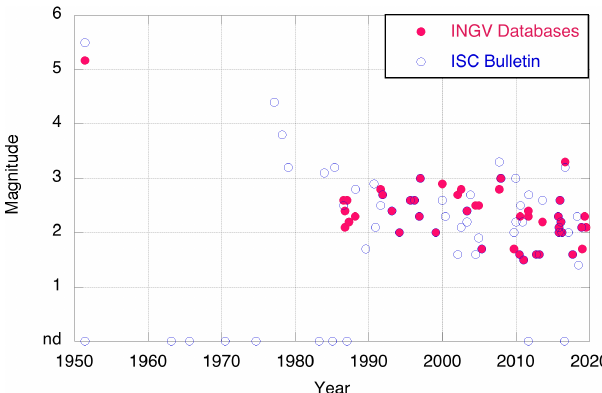
Figure 4. Magnitude versus time plot of earthquakes located within 30km distance of the reservoir, as reported in the INGV databases and ISC Bulletin. The INGV data come from CPTI15 (Rovida et al., 2021) and ISIDe databases (ISIDe, 2007): 46 events with M > 1.5 are reported in the time interval 1985–2019. The ISC data start with the 1951 event and end in 2018. Magnitudes are not uniform and in some cases are not defined (see the blue circles labelled as nd along the x axis): in the case of multiple magnitudes no conver- sion rules are adopted, and values are selected on priority criteria ( M W >M S >M L >M D